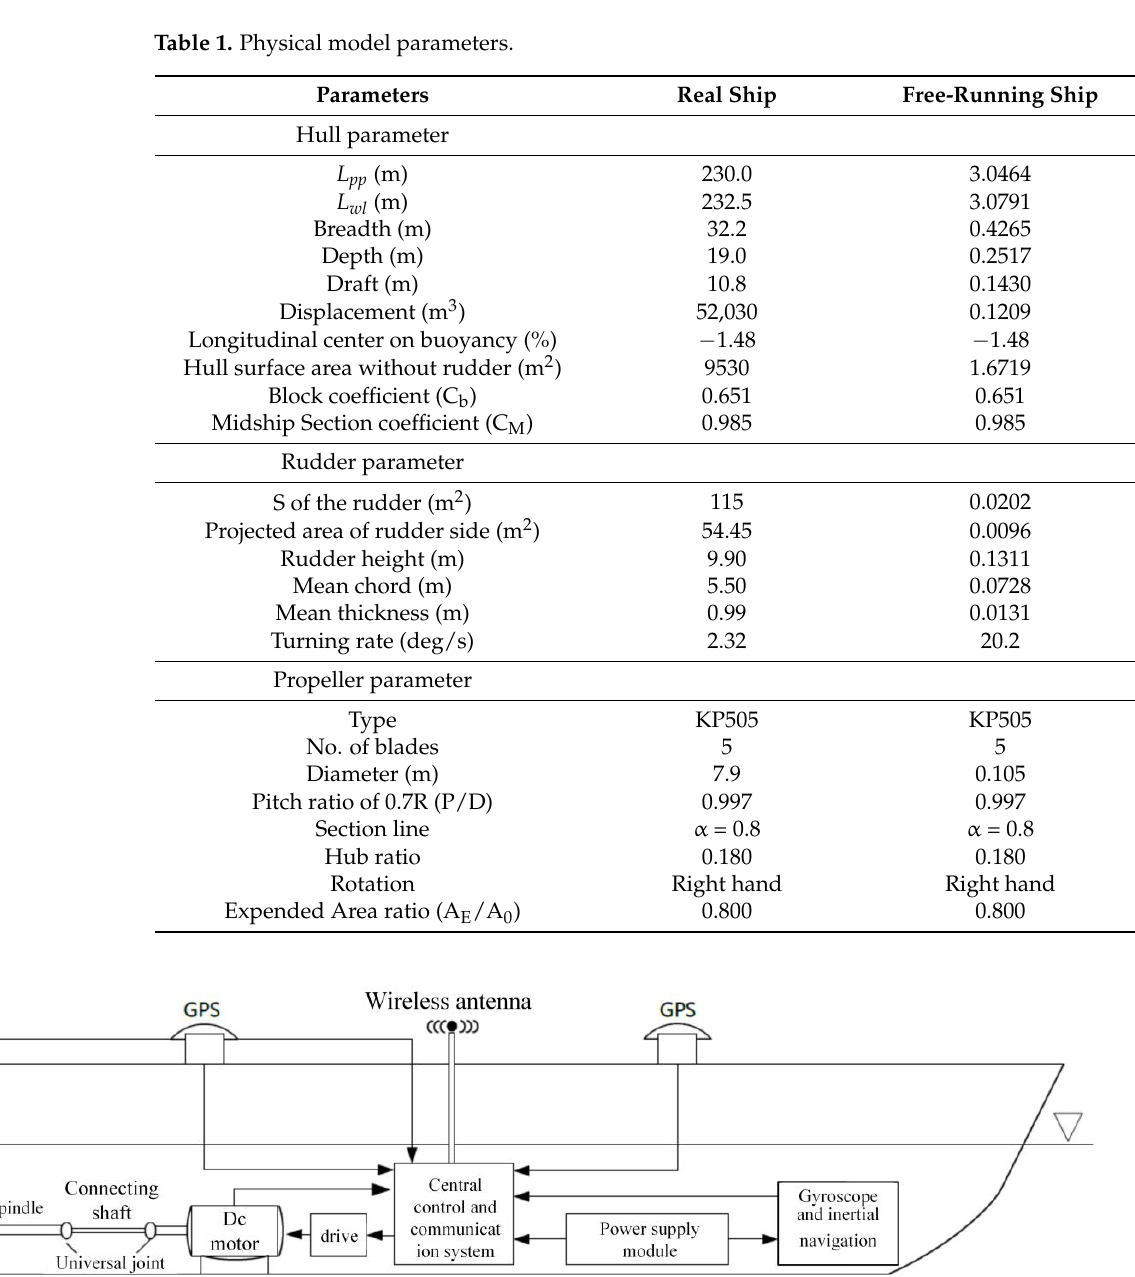
Figure 5. Objective view of the physical model. Table 1. Physical model parameters. Parameters